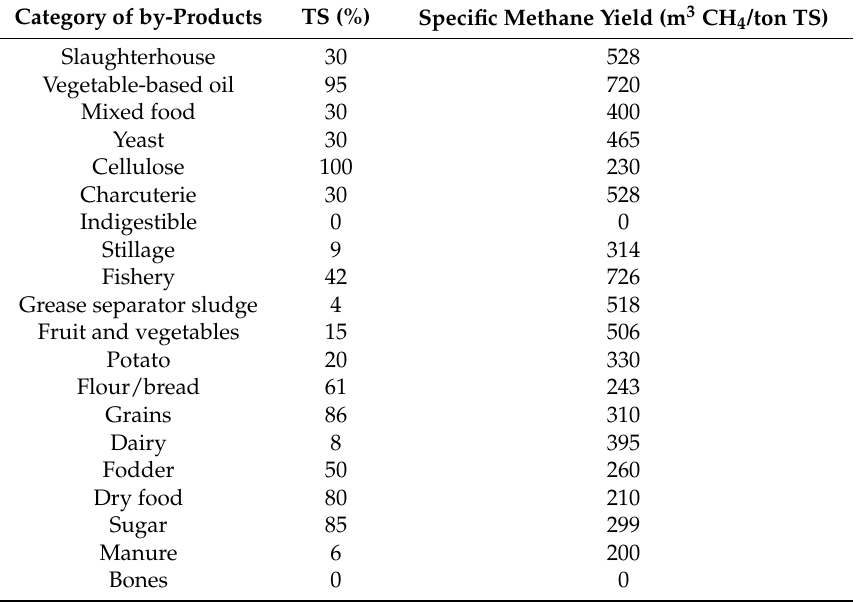
Table A1. Biogas yield from different substrates [23]. TS means total solids.